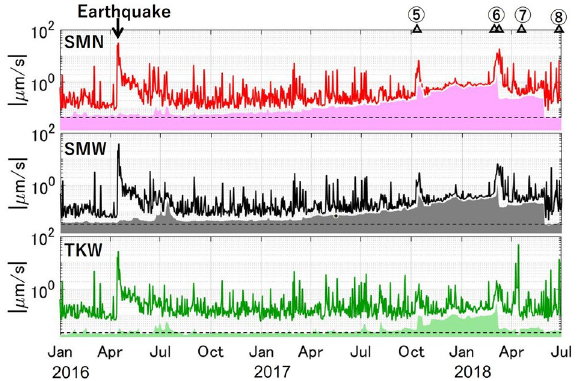
Figure 3. Comparison between RSEM (lines) and SBL at SMN, SMW, and TKW (patched areas) from 2016 to 2018. The horizontal dashed lines are put as a reference of the normal level. Figure S4 shows the comparison at all the stations during the whole